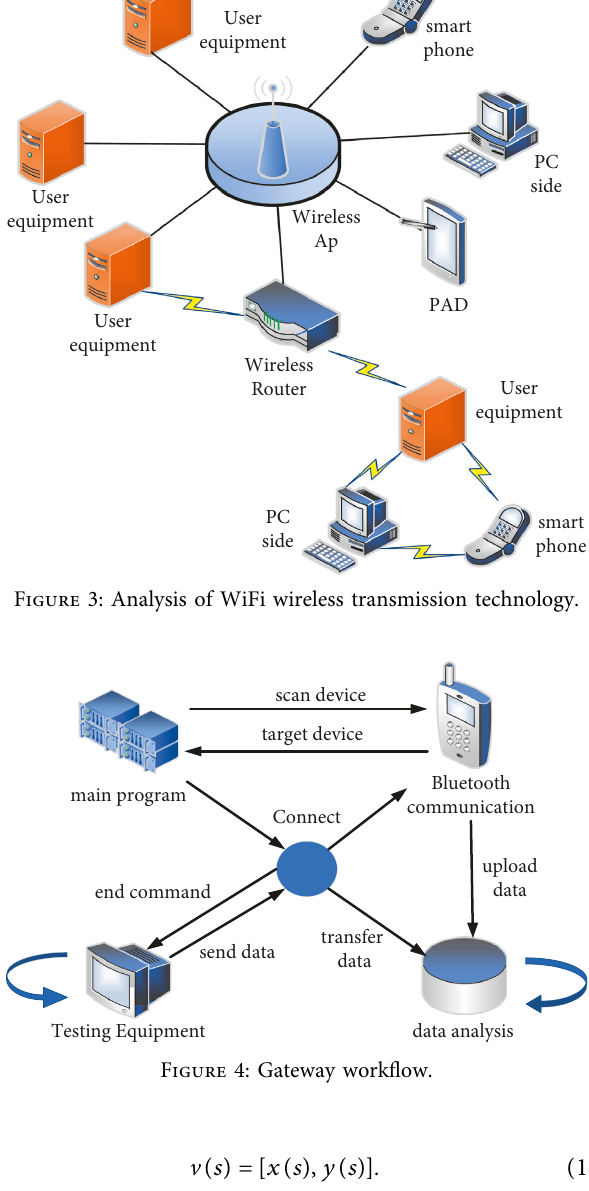
Figure 4: Gateway